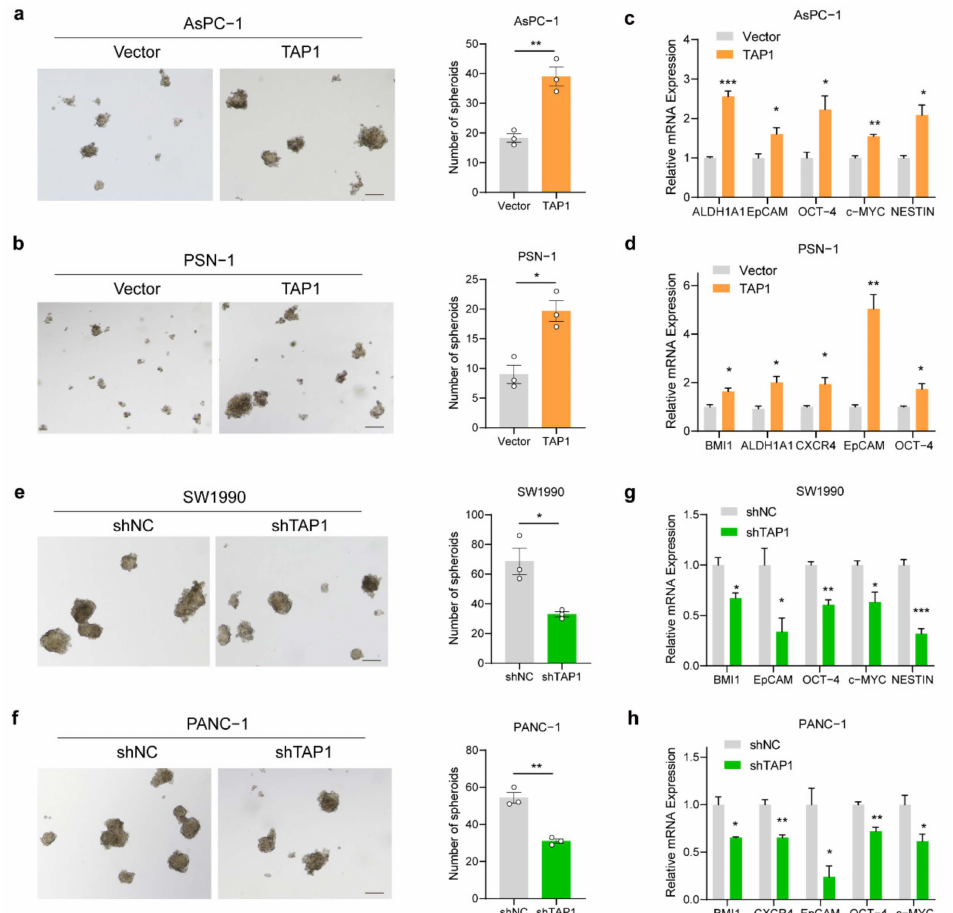
Figure 6. TAP1 (ABCB2) expression enhanced the stemness of PDAC cells. ( a , b ) Representative images of spheroid formation assay in TAP1-overexpressing cells compared with their vector control cells, cultured for 10 days. Scale bars 200 µ m. Quantification of spheroids number is shown at the right. ( c , d ) The mRNA levels of cancer stemness-related markers genes assessed by qRT-PCR in TAP1- overexpressing and control (vector) cells. ( e , f ) Representative images of spheroid formation assay in TAP1-knockdown cells compared with their vector control cells, cultured for 10 days. Scale bar 200 µ m. Quantification of spheroids number is shown at the right. ( g , h ) Detected by RT-qPCR. The reduction of BMI1, CXCR4, EpCAM, OCT-4, c-MYC, and NESTIN in TAP1-knockdown and